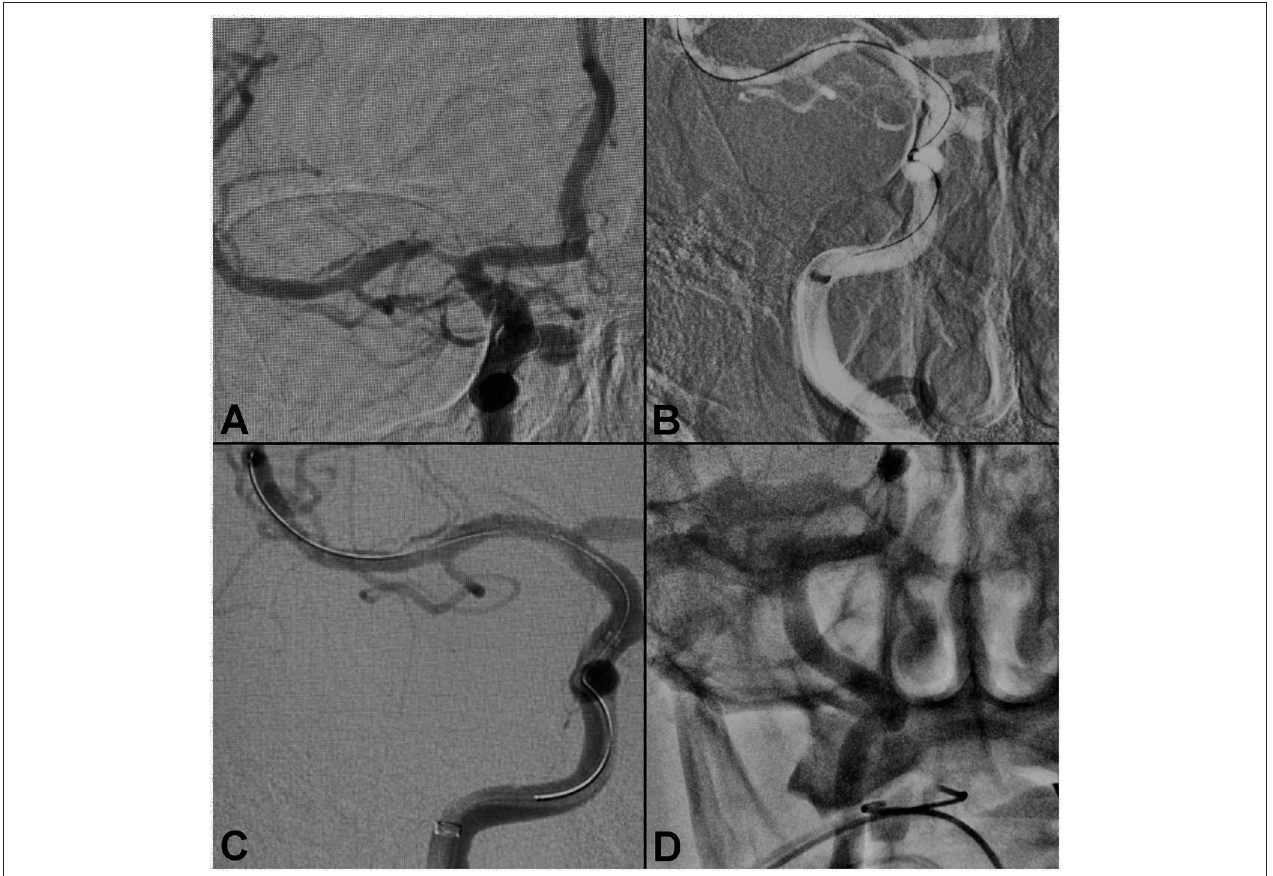
FIGURE 1 | Right middle cerebral artery stenosis. (A) Pre-procedure angiogram demonstrating intracranial stenosis of the right M1-MCA segment. (B) Ballast position in the ICA petrous segment. (C) Post-balloon mounted stent deployment. (D) Final angiography showing no evidence of vasospasm or